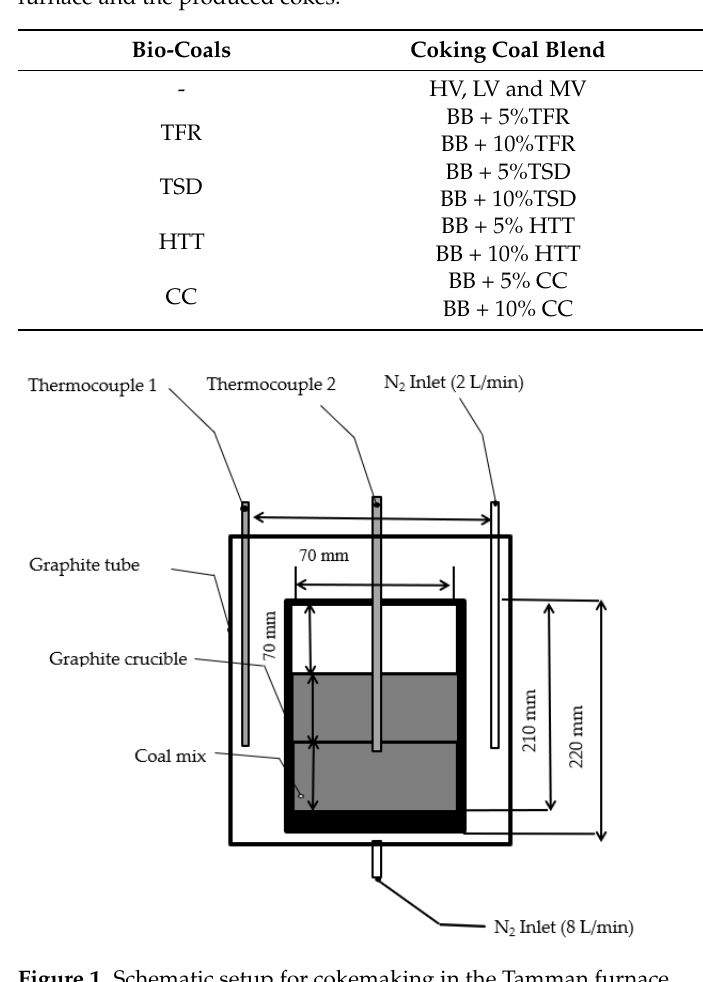
Figure 1. Schematic setup for cokemaking in the Tamman furnace.